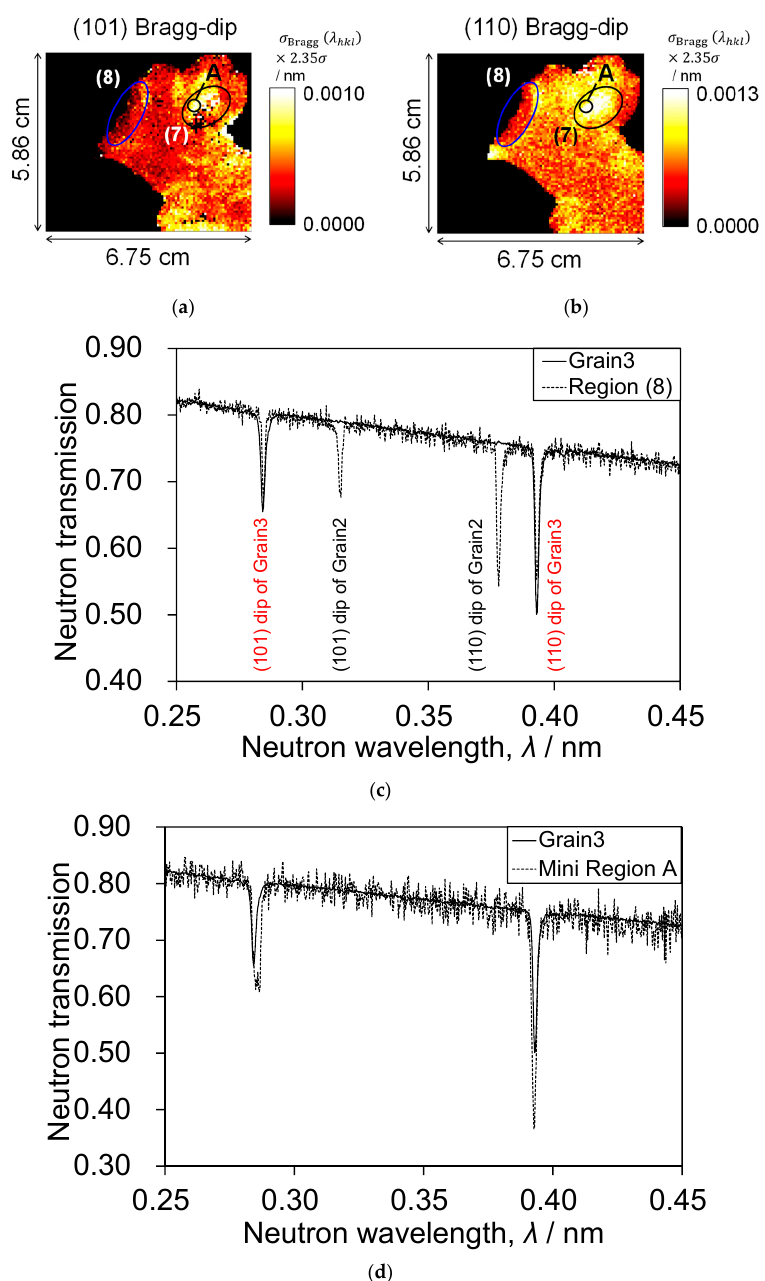
Figure 8. ( a ) Imaging of the integrated intensity of (101) Bragg-dip in Grain 3. ( b ) Imaging of the integrated intensity of (110) Bragg-dip of Grain 3. ( c ) Comparison of the neutron transmission spectra at entire Grain 3 and Region (8). ( d ) Comparison of the neutron transmission spectra at entire Grain 3 and Mini Region A.